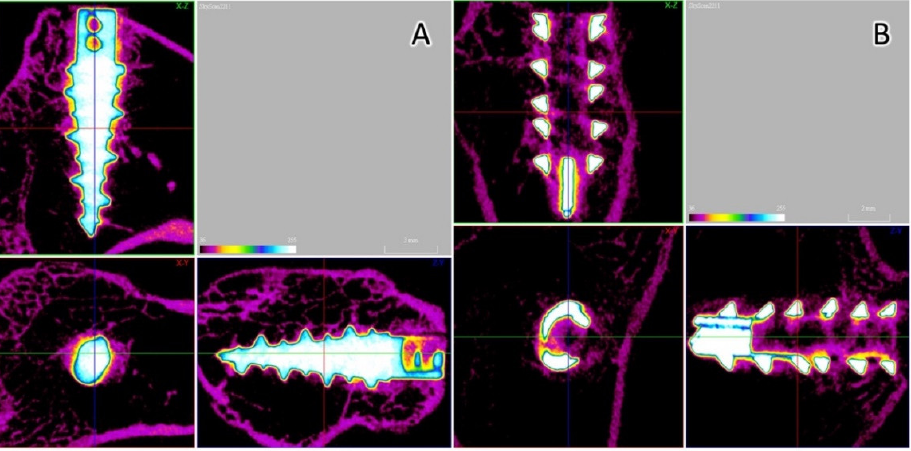
Figure 11. Micro-CT analysis. ( A ) Titanium SA 2 weeks after implantation. The BV fraction was 27.77% and the bone surface (BS) density was 4.52 mm −1 . ( B ) Iron SA 2 weeks after implantation. The BV fraction was 38.20% and the BS density was 6.05 mm −1 .